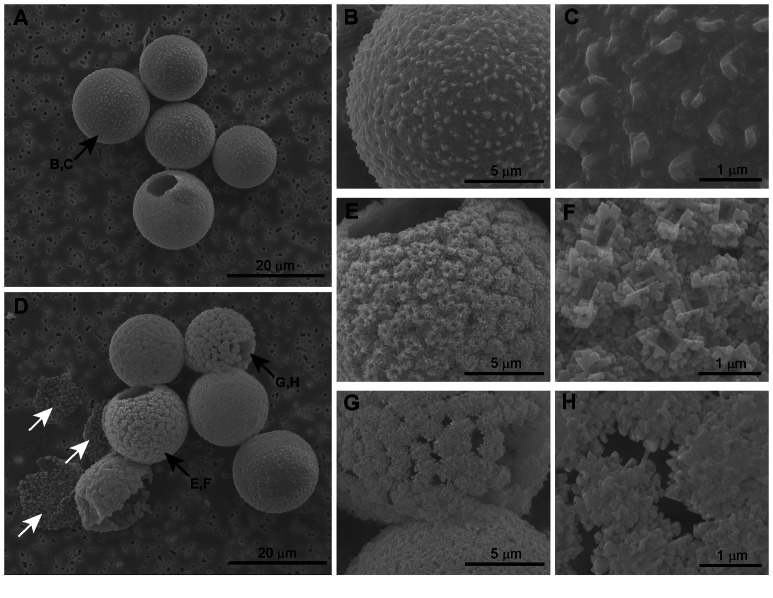
Effect of elevated pCO2 on cyst morphology.Cells grown under (A–C) 150 µatm CO2 and (D–H) 1400 µatm CO2. Black arrows indicate cysts that are shown in detailed images, white arrows show collapsed cysts.